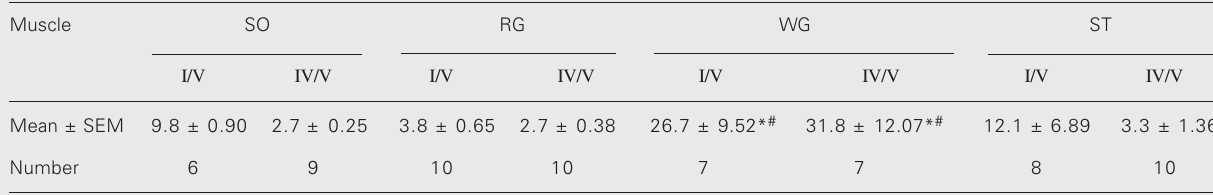
Quantitative data were obtained from the ratio of the activity and the internal standard of each muscle. RG = red gastrocnemius; SO = soleus; ST = semitendinosus; WG = white gastrocnemius. I/V : *P < 0.001 compared to RG; # P < 0.05 compared to SO. IV/V : *P < 0.01 compared to RG and ST; # P < 0.05 compared to SO (one-way